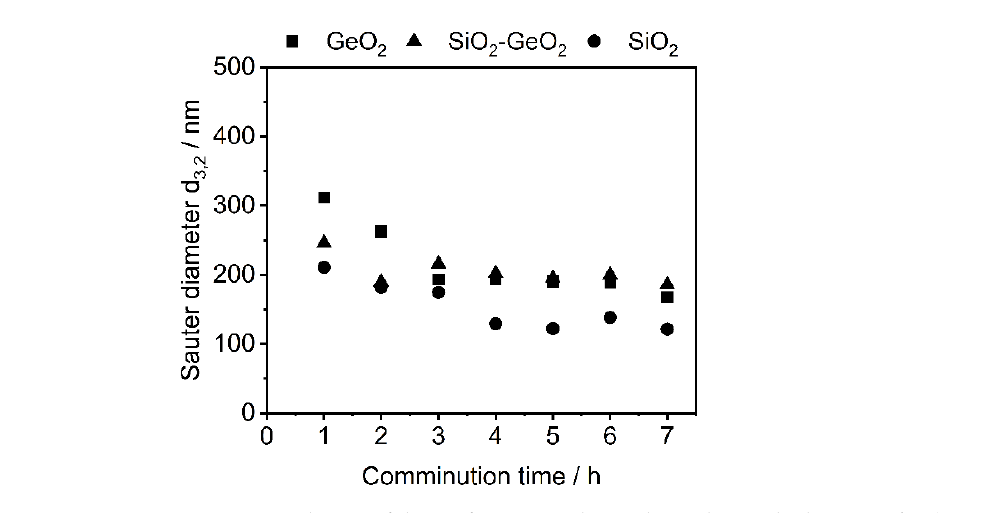
Figure 3. Evolution of the surface-equivalent spherical particle diameter d 3,2 (Sauter diameter) with increasing comminution time.